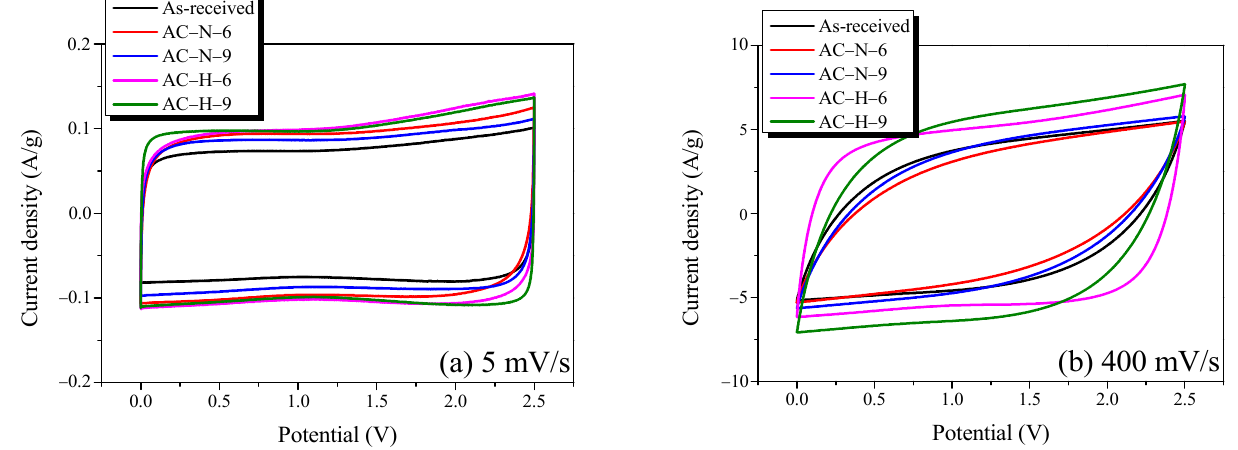
Figure 9. Cyclic voltammograms of AC heat-treated under different conditions: ( a ) 5 mV/s; ( b ) 400 mV/s.